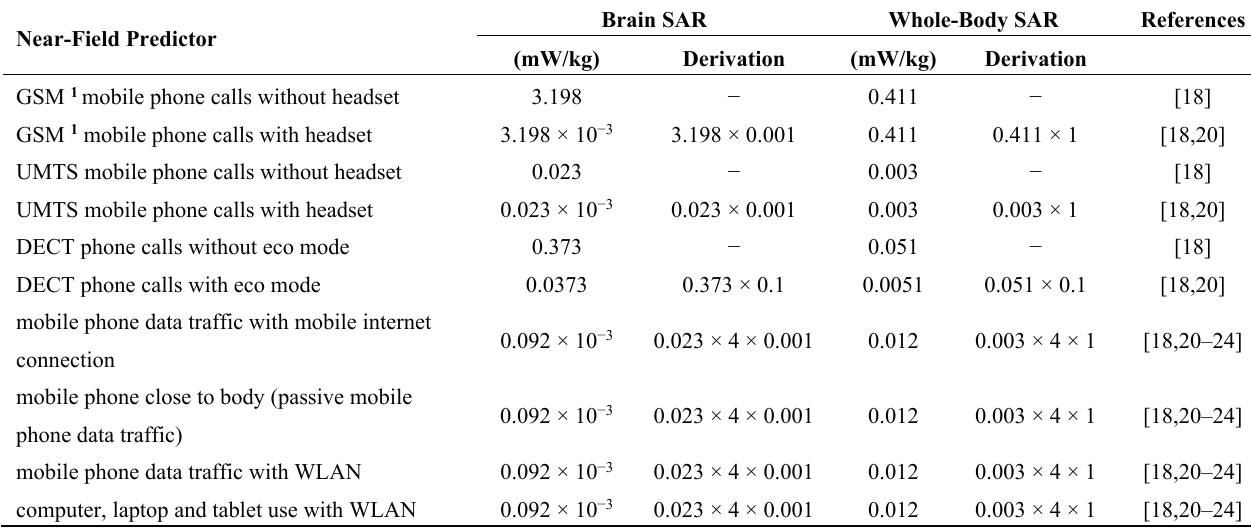
Table 2. Near-field brain and whole-body SARs, corresponding derivation and references for the near-field